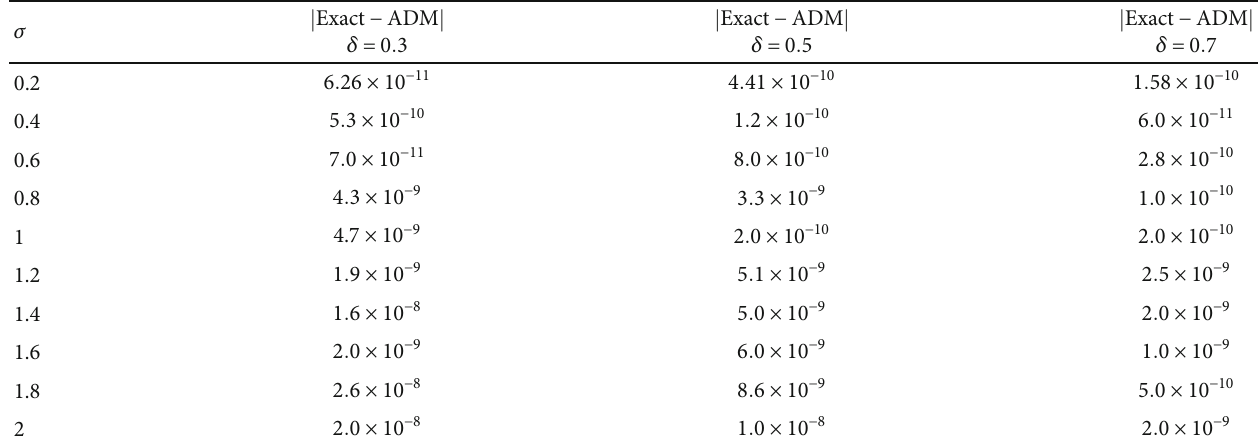
Figure 6: 2D plots for approximate solution of Example 5.2 at τ = 0 : 25,0 : 5,0 : 75,1 . Table 1: Absolute error of Example 5.1 at τ = 0 : 8 .